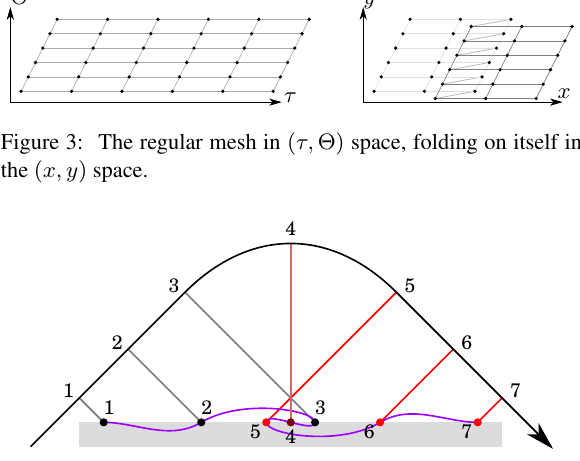
Figure 4: Folding of the regular mesh (purple) due to the trajec- tory curvature.